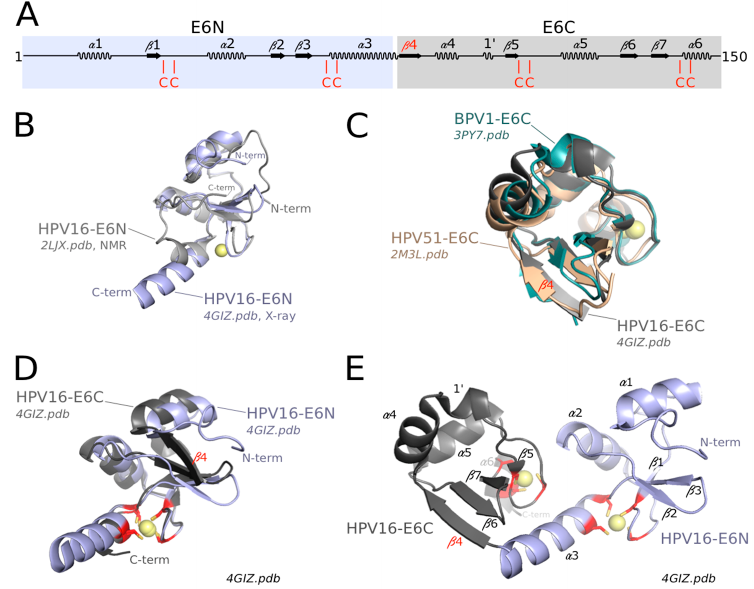
Figure 2. Architecture of mammalian human papillomavirus (HPV) E6. ( A ) Secondary structure elements of mammalian HPV16 E6. E6N is shaded in blue, E6C is shaded in gray; ( B ) Superimposition of HPV16 E6N domain solved by NMR [91] and HPV16 E6N domain from the crystal structure of the E6/E6AP LxxLL complex [75]; ( C ) Superimposition of HPV16 E6C domain from the crystal structure of the E6/E6AP LxxLL complex [75], HPV51 E6C domain solved by NMR [101] and bovine papillomavirus 1 (BPV1) E6C domain from the crystal structure of the BPV1 E6/paxillin LxxLL complex [75]; ( D ) Superimposition of HPV16 E6N and E6C domains from the crystal structure of the HPV16 E6/E6AP LxxLL complex [75]; ( E ) Structure of LxxLL-bound mammalian HPV16 E6 [75] (LxxLL motif not shown for clarity). Zinc-coordinating cysteines are highlighted in red. Secondary elements are numbered as in [75]. Spheres are Zinc (II) atoms. All structural views in this article were